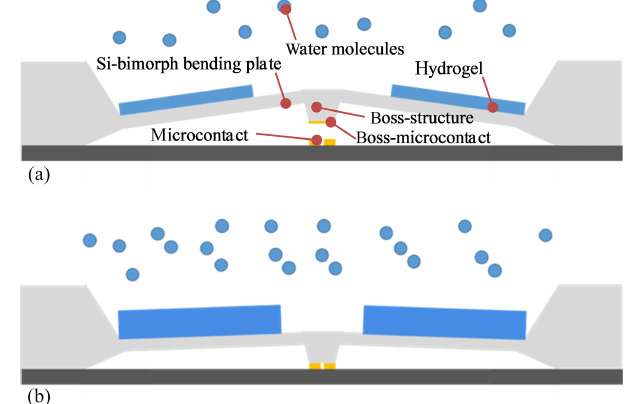
Figure 1. Humidity threshold sensor switch, consisting of a bi- morph bending plate with boss structure, a patterned hydrogel layer and microcontacts, (a) open, (b)